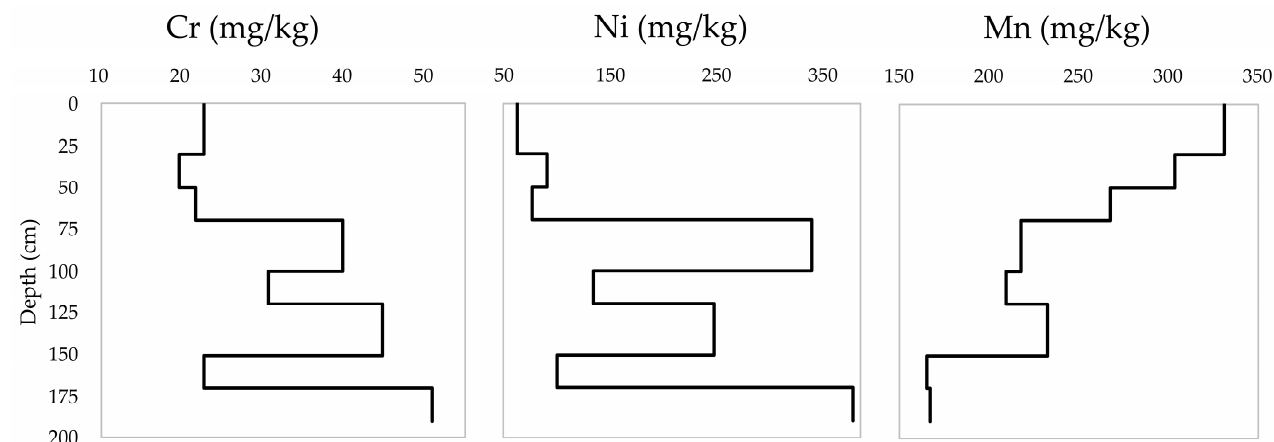
Figure 4. Vertical distribution of Cr, Ni and Mn concentrations in mg/kg.